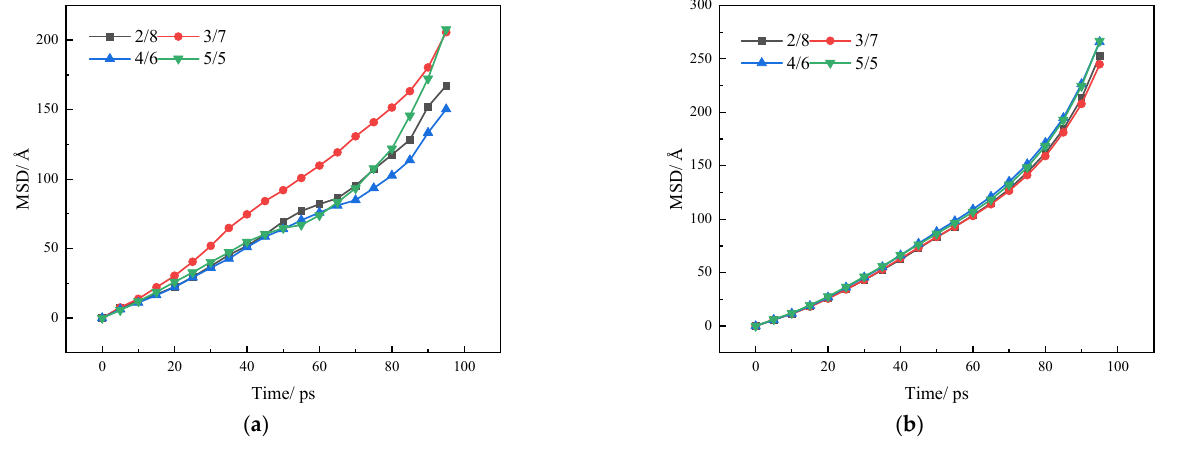
Figure 10. MSD of mutual diffusion between asphalt and SBS. ( a ) MSD of SBS diffusion in asphalt, ( b ) MSD of asphalt diffusion in SBS.